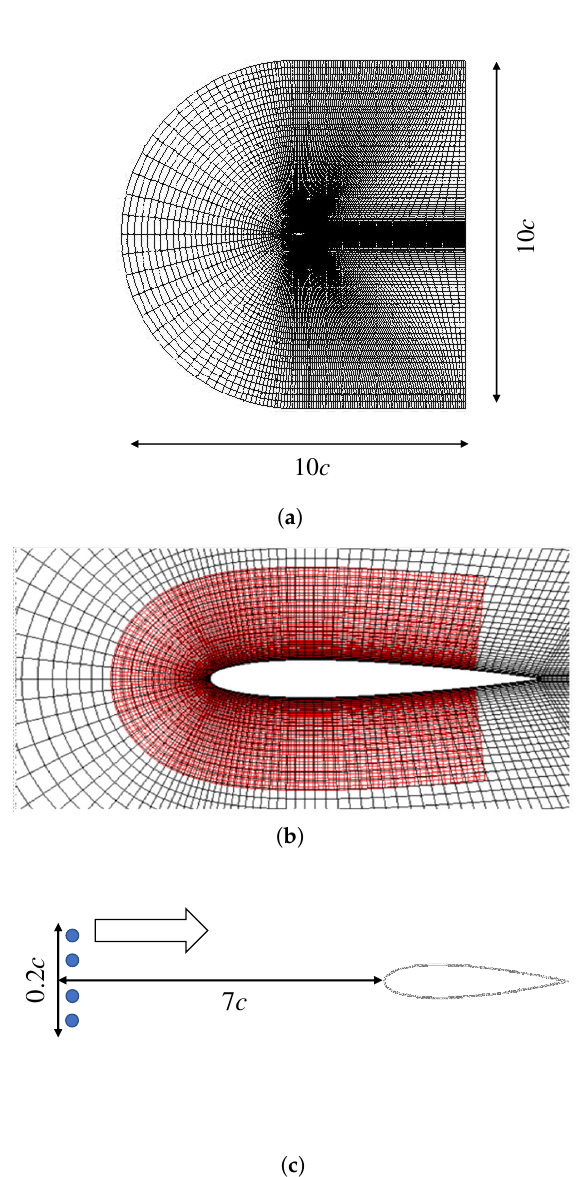
Figure 1. Computational domain and grid for the NACA0012 icing simulation: ( a ) complete domain; ( b ) zoomed-in view around the wing (the main and sub grids are shown in black and red, respectively); ( c ) initial position of